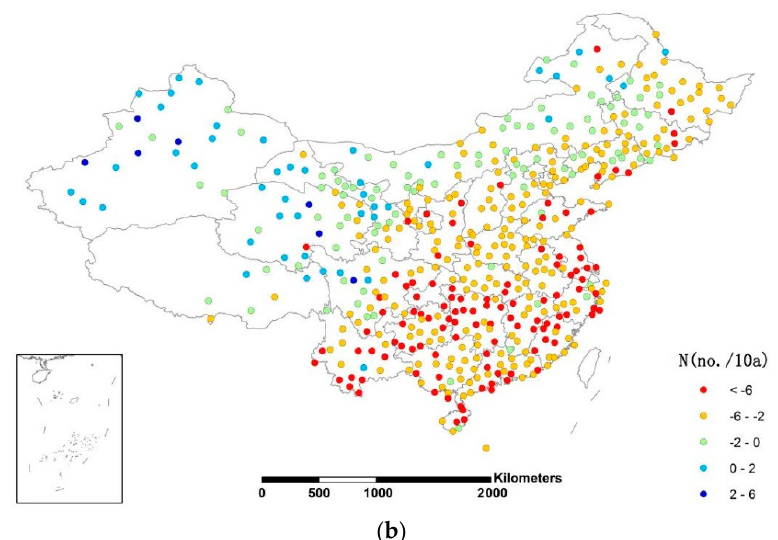
Figure 7. Trends of ( a ) mild-intensity and ( b ) lower-intensity precipitation evaluated by the climate trend rate method.